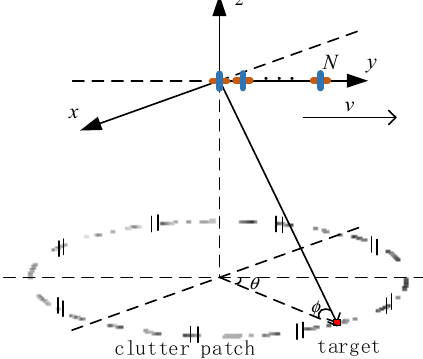
Figure 1. The geometry of polarimetric radar array.